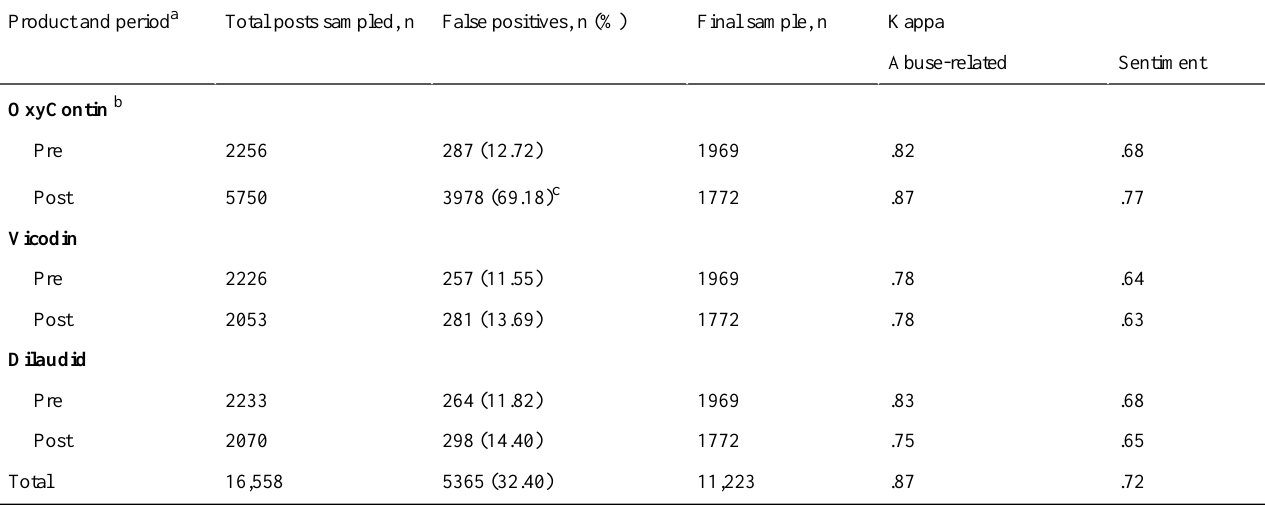
Table 1. Content analysis: number of posts sampled and retained, false positive rate, and interrater agreement kappa